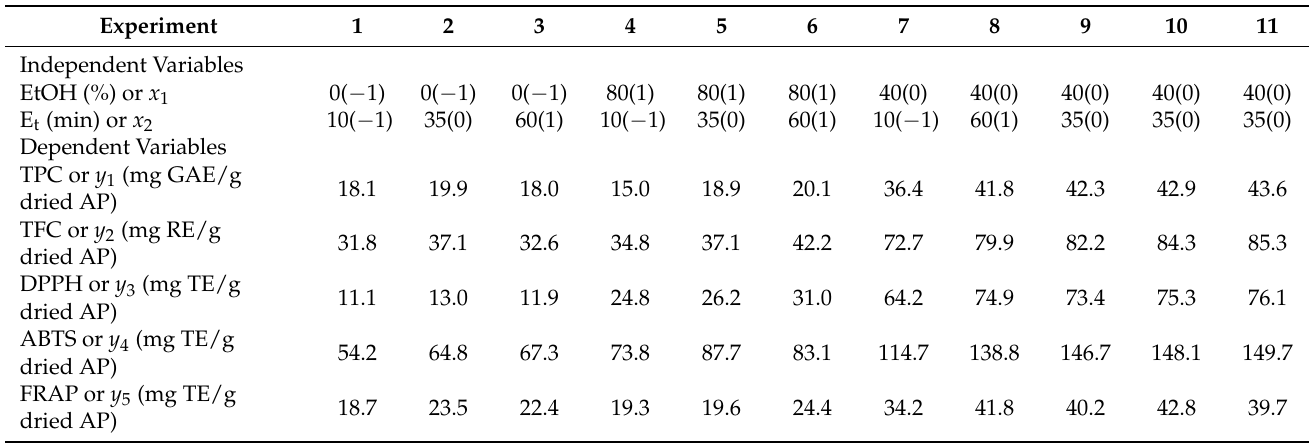
Table 2. Operational conditions assayed (expressed in terms of coded and uncoded independent variables) and experimental values obtained for response